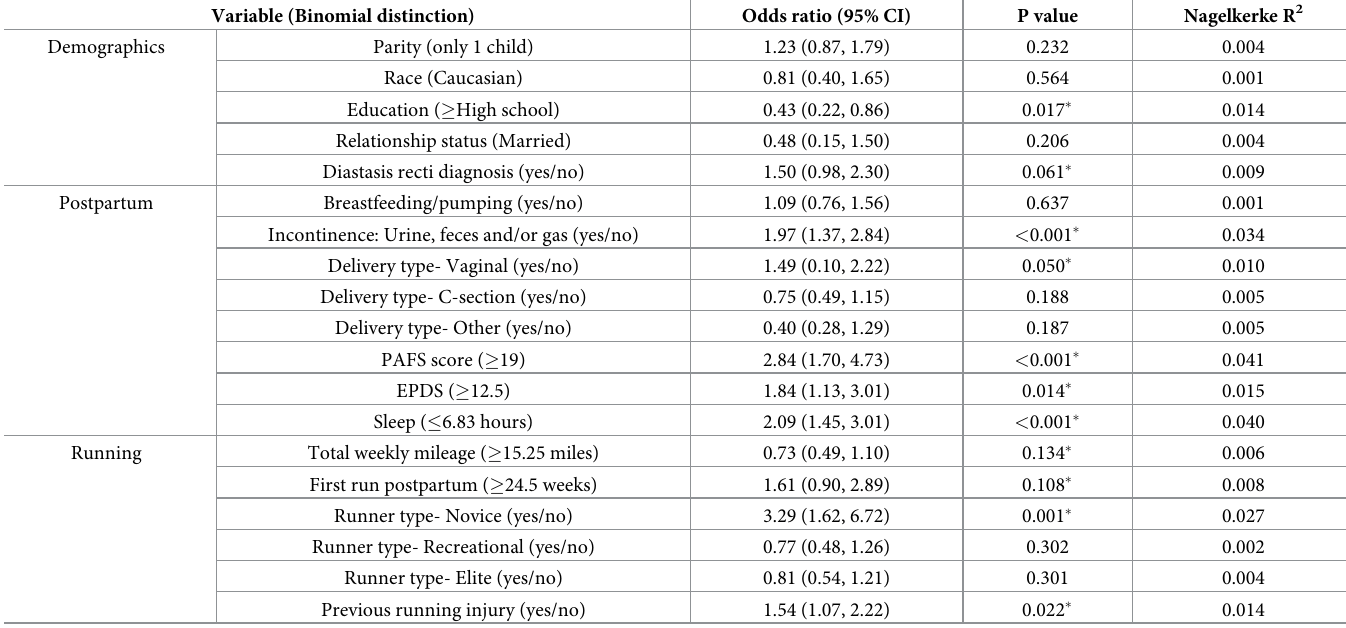
Table 2. Bivariate relationship between risk factors and having current pain with running.